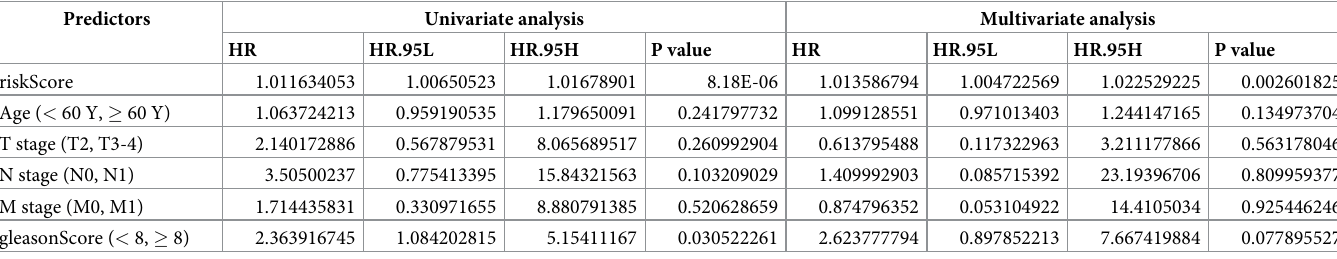
Fig 9. Using ICGC data, the ROC curve and dynamic AUC line were used to evaluate the prognostic prediction ability of four lncRNA histograms. The ROC curve and the area under the dynamic curve (AUC) during 1 (A), 3 (B) and 5 (C) years of follow-up were plotted. https://doi.org/10.1371/journal.pone.0249951.g009 Table 4. TCGA OS-related univariate as well as multivariate Cox regression analysis.